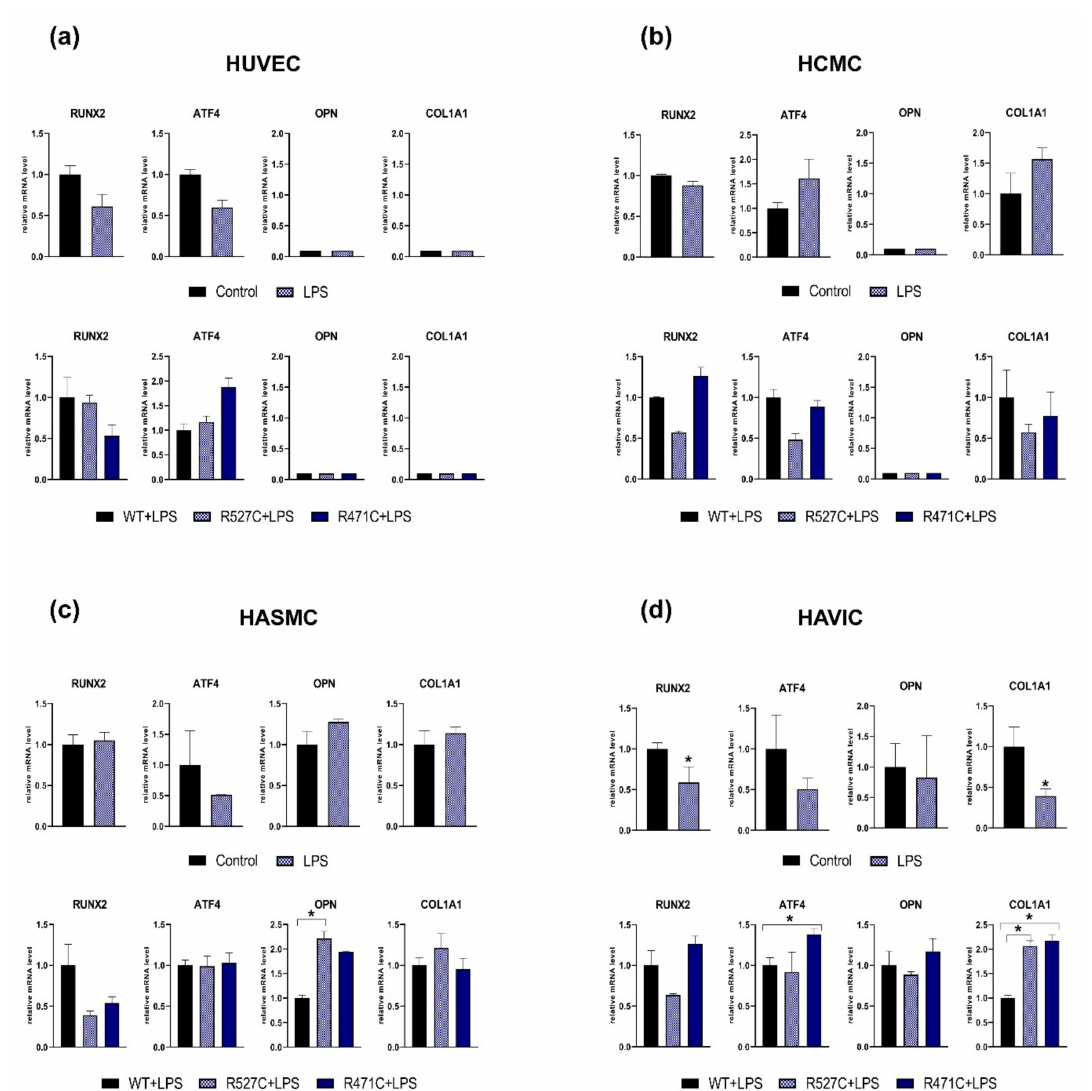
Figure 2. The effect of LMNA R527C and LMNA R471C mutations on the osteogenic marker expression in undifferentiated human mesenchymal cells with the presence of LPS. Upper panel for each type of cells HUVEC ( a ), HCMC ( b ), HASMC ( c ) and HAVIC ( d ) represents analysis of osteogenic marker expression by qPCR in undifferentiated cells without LPS (Control) and in the presence of LPS (LPS). Lower panel for each types of cells (a, b, c, d) represents the analysis of osteogenic marker expression by qPCR in cells transduced with lentivirus bearing either LMNA W T (WT) or LMNA R527C /LMNA R471C (R527C/R471C). The results are represented as mean ± SD; * p <